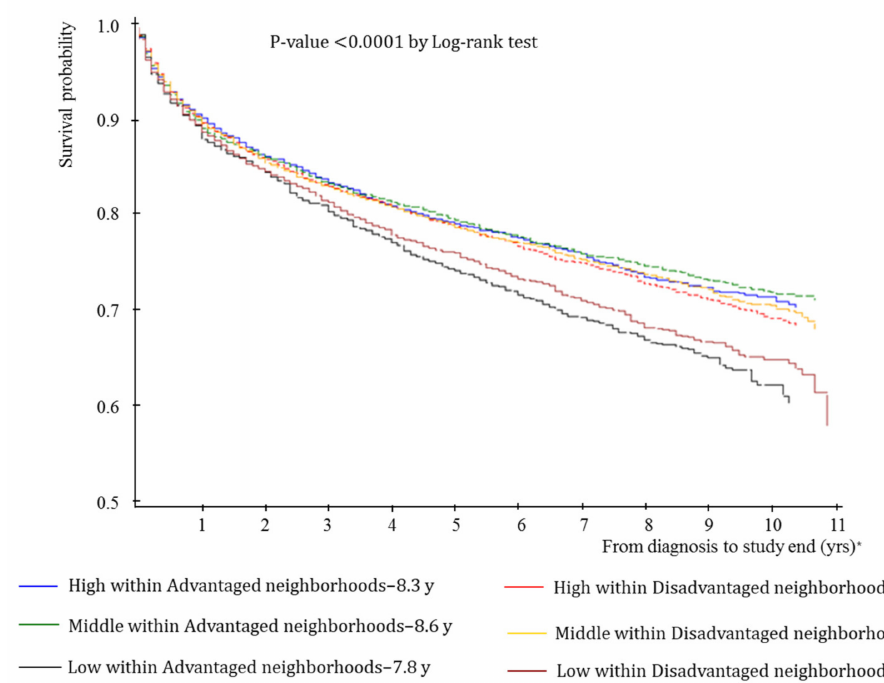
Figure 3. All-cause mortality survival probability stratified by individual household income in advantaged and disadvantaged communities. * yrs: